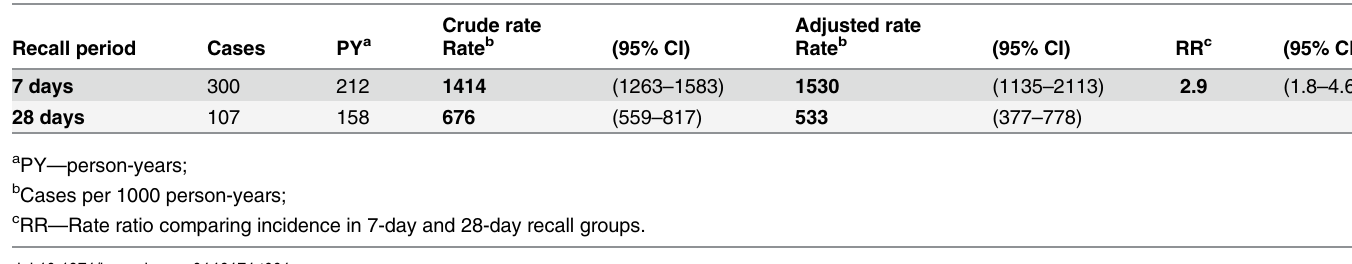
Table 1. Incidence rate of overall IID in the Telephone Survey by recall